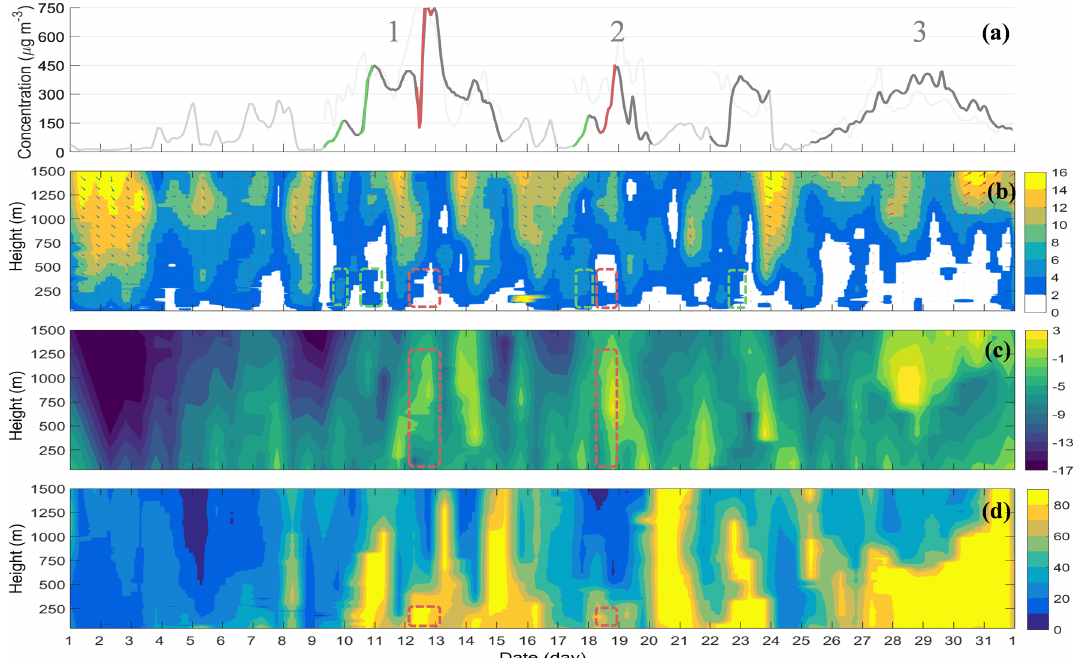
Figure 1. Temporal variations in urban mean PM 2 . 5 and vertical distributions of meteorological factors in January 2013. (a) PM 2 . 5 mass concentration (dark gray or gray: Beijing; light gray: Baoding); (b) winds (vectors; red vectors: southwesterly winds) and wind velocity (shadings; units:ms − 1 ); (c) temperature (shadings; units: ◦ C); (d) RH (shadings; units: %). Green boxes: rising processes; red boxes: cumulative explosive